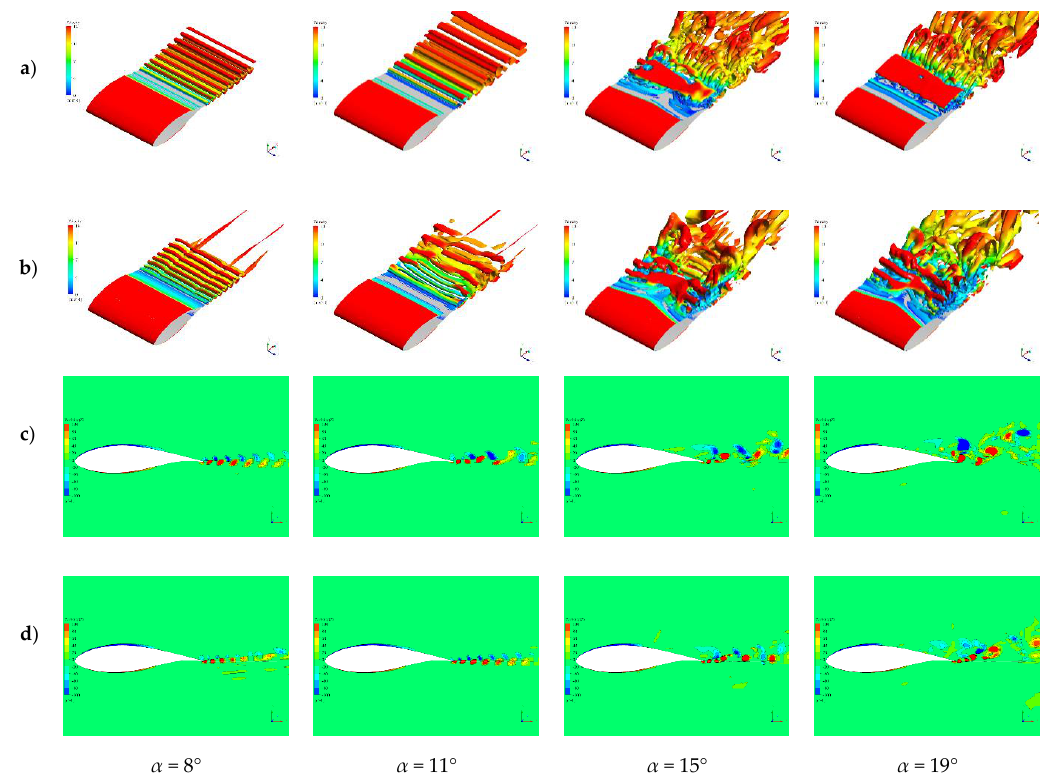
airfoil. At the 8° and 11° angles of attack, the complete vortex was formed along the trailing edge of the airfoil without the NLPS, and the corresponding vorticity nephogram shows that the spanwise vortex periodicity was downward. At this time, both the vortex scale and the radius of the vortex core were larger, indicating that the strength of the trailing edge vortex was greater. For the airfoil with the NLPS, the trailing edge shedding vortices interfered with the NLPS. Under the action of the NLPS, the trailing edge shedding vortices were broken into smaller scale vortices. The corresponding vorticity nephogram shows that the scale of the vortices was weakened at this time and the strength of the trailing edge shedding vortices was weakened, so the noise reduction effect of the NLPS at these two angles of attack was obvious. At the 15° and 19° angles of attack, large scale flow separation occurred on the tail edge of the upper surface. At this time, the large scale separation vortex was broken into a number of small vortices; the NLPS was in the separation area and did not play the role of breaking the direction of the vortex.